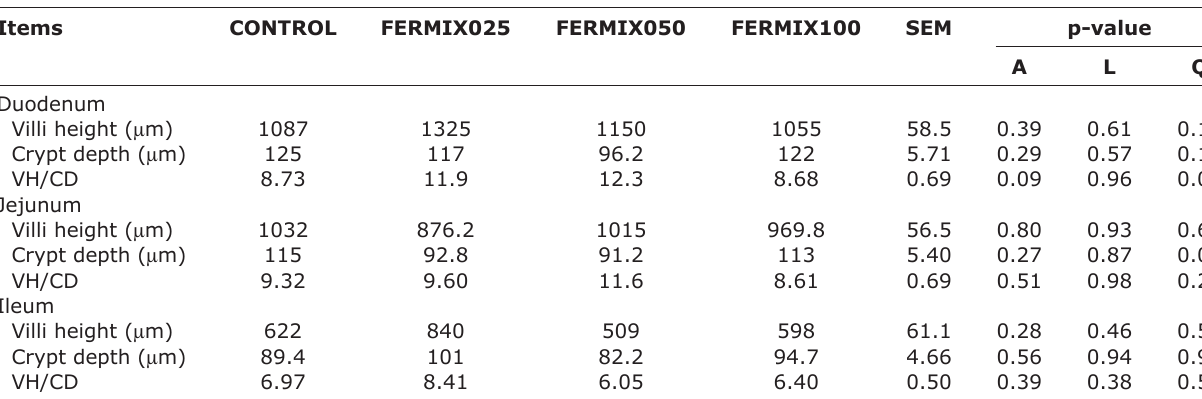
Table-7: Intestinal morphology of broiler chickens.